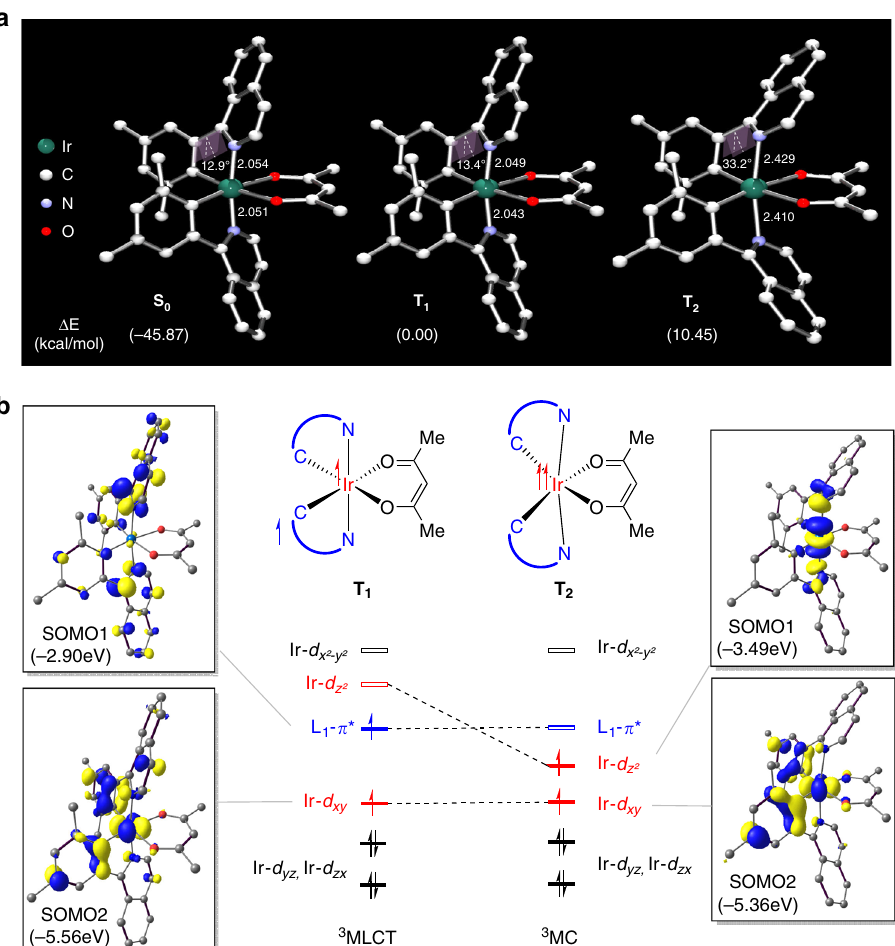
Fig. 2 Various aspects in the excitation of the (piq) 2 Ir(acac). a DFT-optimized structures of the S 0 , T 1 and T 2 state of (piq) 2 Ir(acac). b Qualitative Walsh diagram illustrating the most important change in the ordering of the frontier orbitals in the two triplet states of Ir-complex. All bond lengths are in